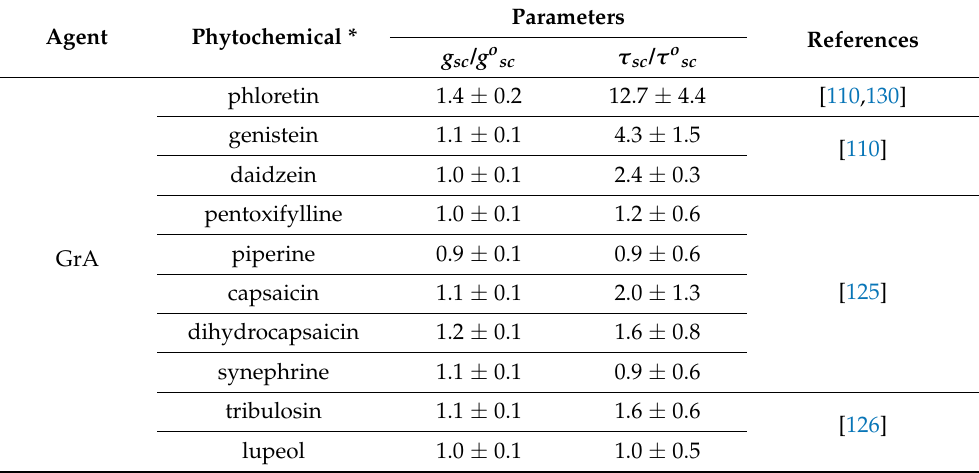
Table 2. The effects of phytochemicals on the properties of ion channels formed by gramicidin A, syringomycin E, and amphotericin